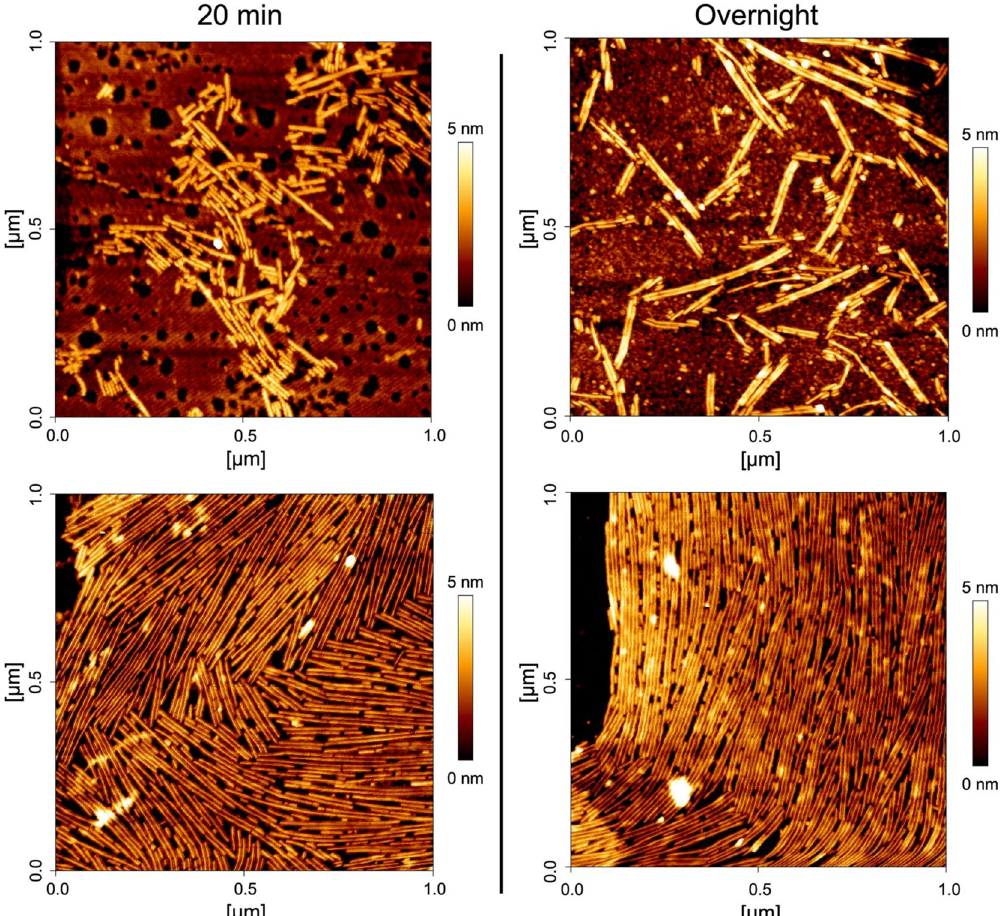
Figure 4. SC16ΔN self-assembles into rodlets. A 50 μL drop of SC16 ΔN in dH 2 O (left: 10 μg/mL; right: 5 μg/ mL) was incubated on freshly cleaved highly oriented pyrolytic graphite at room temperature for (left) 20 min before wicking excess solution and drying overnight or (right) allowing to dry overnight. Rodlets were then imaged using atomic force microscopy and a representative image from two samples for each condition is